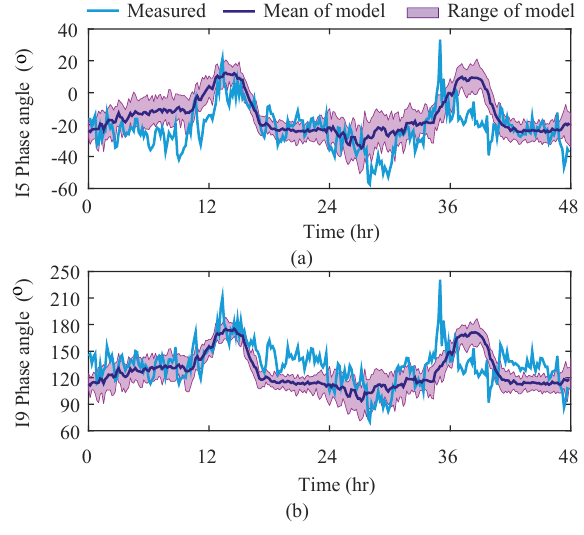
Figure 11. Comparison of the measured and the mean of the simulated results of the relative harmonic phase angle ( N MC values at each time instance) ( a ) 5th and ( b )